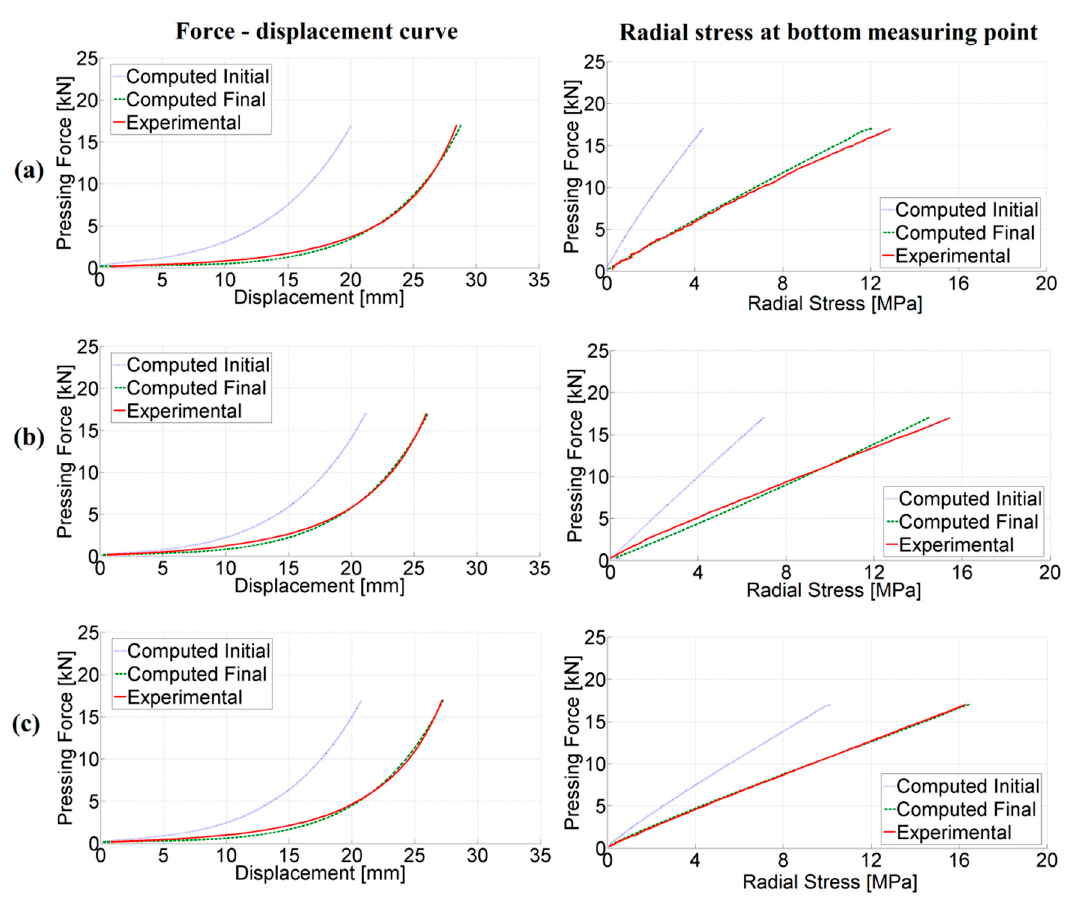
Figure 10. Comparison of experimental and computed measurable quantities from three tests: ( a ) configuration 1; ( b ) configuration 2; ( c ) configuration 3.